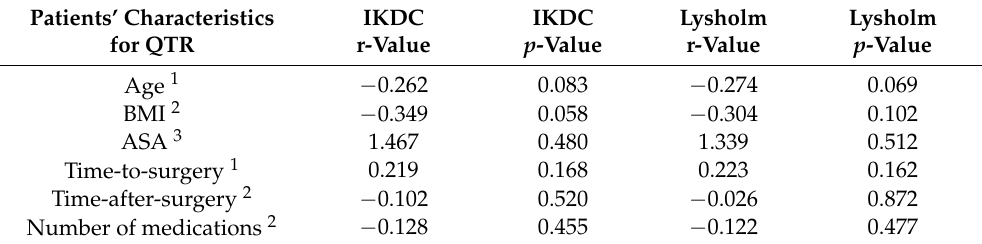
Table 3. Correlation of patient characteristics and patient-related